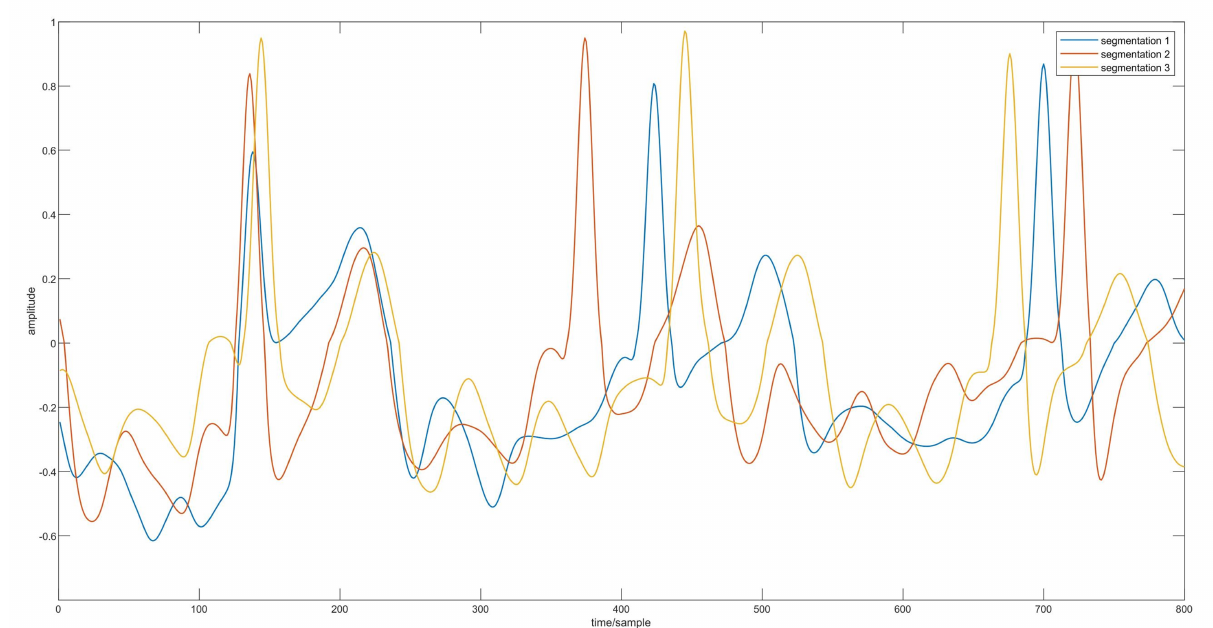
Figure 5. The segmentation diagram of 800 sample